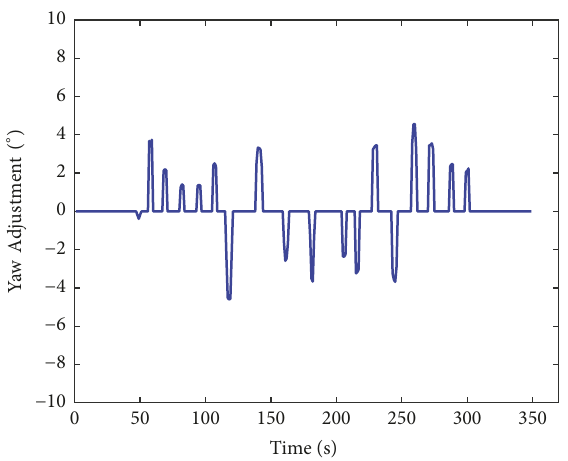
Figure 22: Curves of yaw adjustment output by LSTM45 in complex dynamic